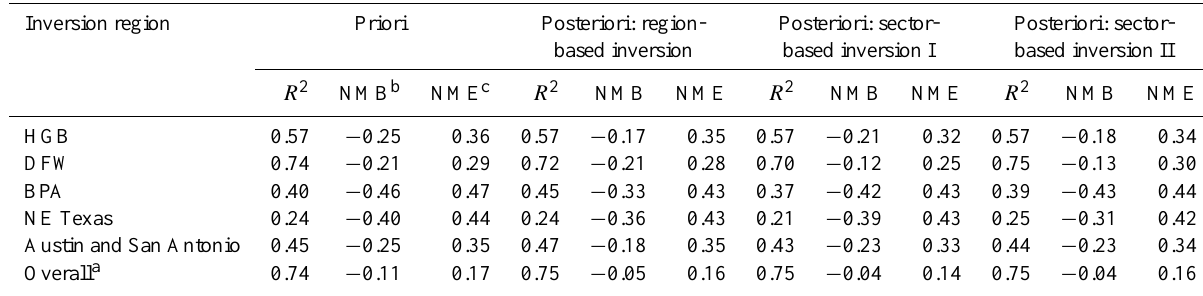
Table 3. Evaluation of CAMx-modeled NO 2 using OMI NO 2 . Inversion region